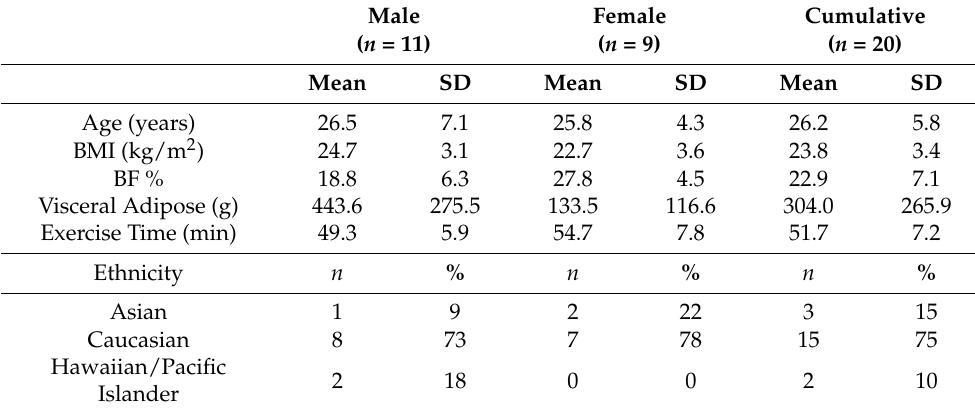
Table 1. Demographic characteristics of